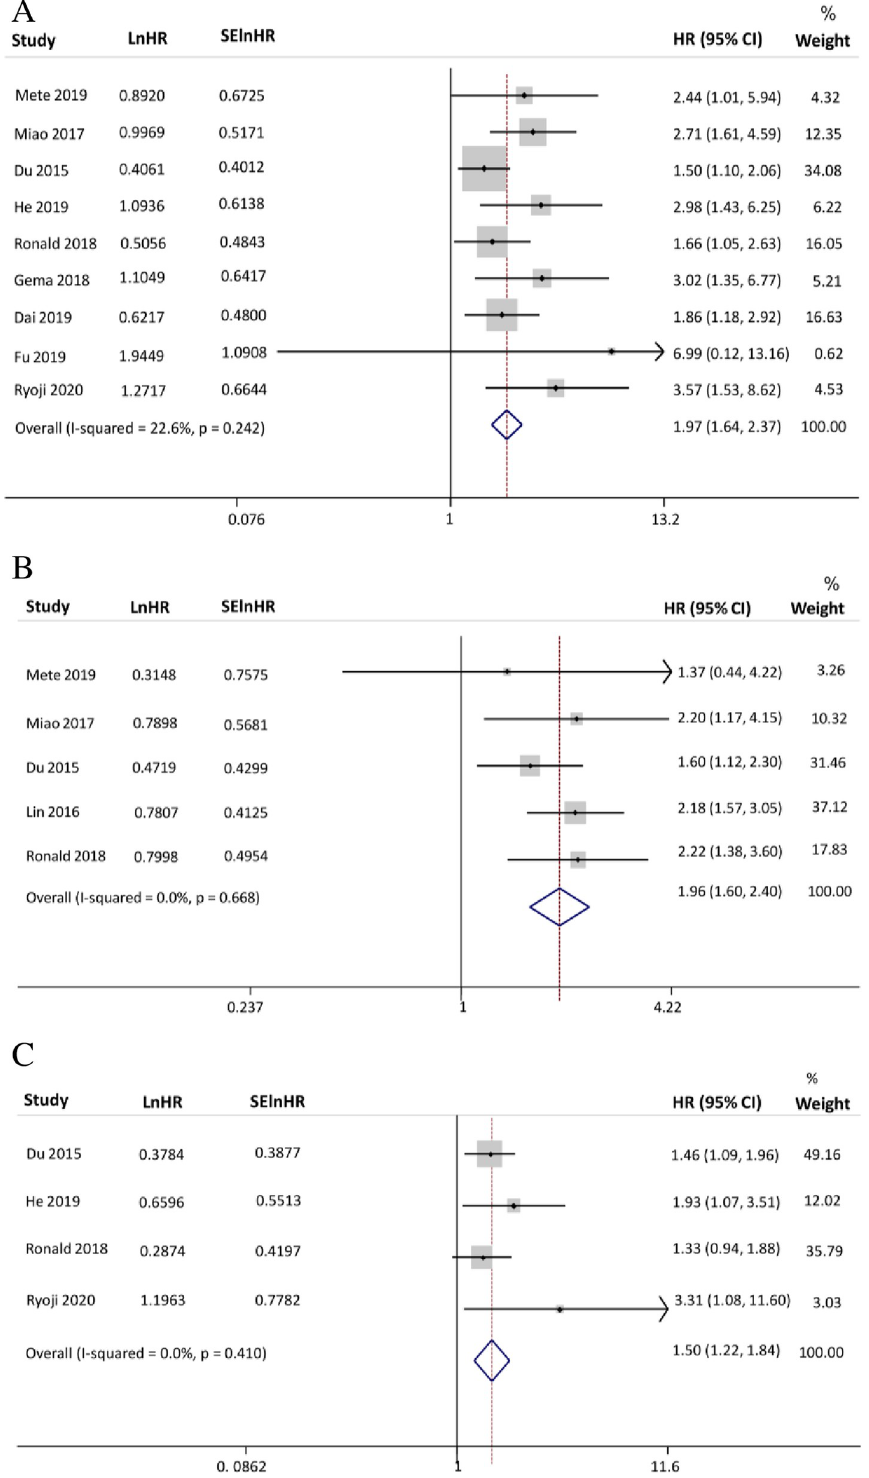
Fig 2. Forest plots of the relationship between the PNI and survival outcomes: A. OS B. DMFS C. PFS.